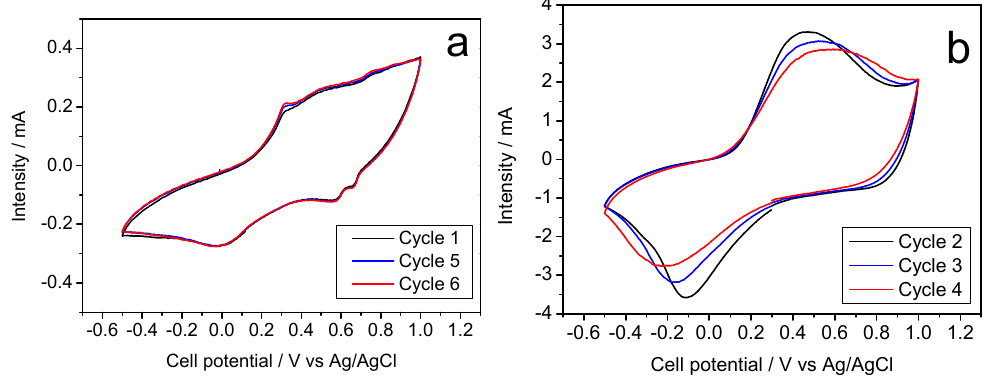
Figure 8. Cyclic voltammetry in aqueous MgSO 4 -based electrolyte and referring the voltages to the Ag/AgCl electrode: ( a ) Na-B/SS and ( b ) K-B/SS.